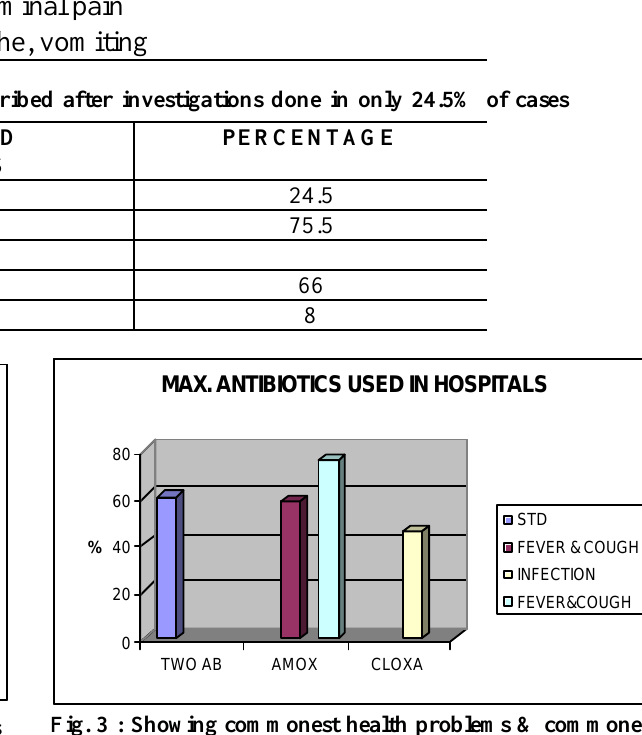
Fig. 1 : Showing average number of prescriptions in hospitals